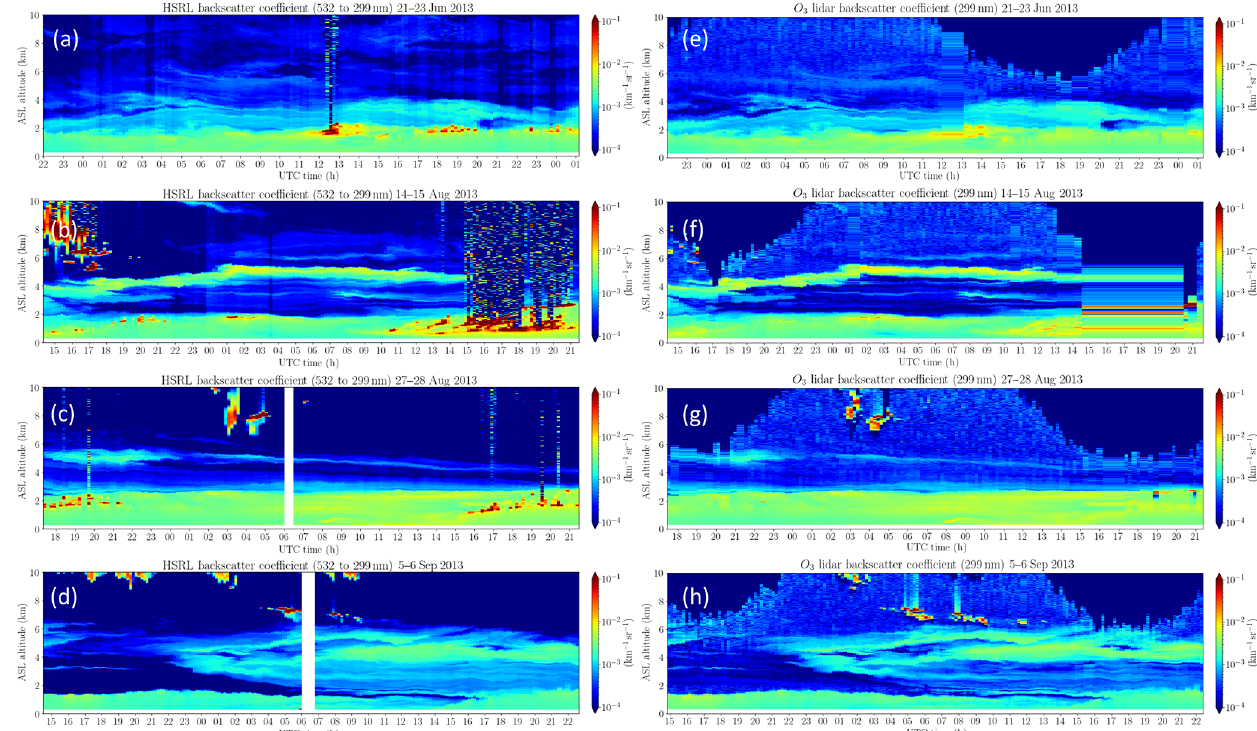
Figure 3. HSRL-converted aerosol backscatter coefficients (a, b, c, d) compared to RO 3 QET lidar-derived aerosol backscatter coefficients at 299nm (e, f, g, h) , with 10min temporal resolution and 30m vertical resolution. The data were taken from 21 to 23 June (a, e) , 14–15 August (b, f) , 27–28 August (c, g) , and 5–6 September (d, h) 2013. The HSRL-converted aerosol backscatter coefficients are scaled from the original retrievals at 532 to 299nm using Eq. (1) and å β = 1 . 34.